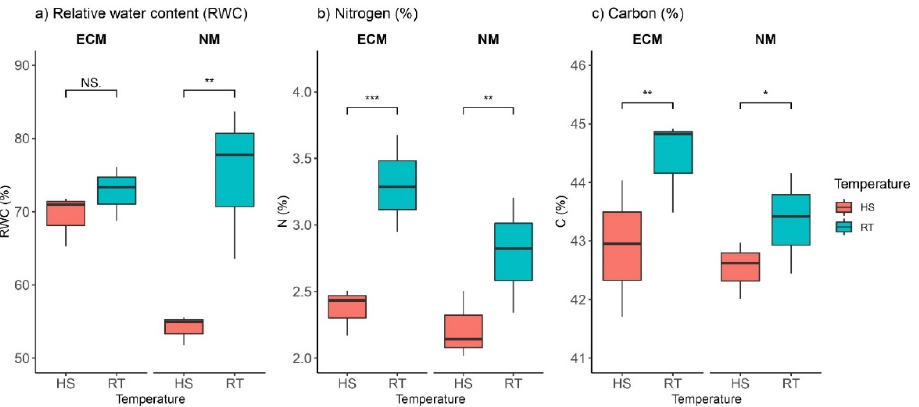
Figure 1. Changes in ( a ) relative water content (RWC, %), ( b ) nitrogen content (N, %), and ( c ) car- bon content (C, %) in leaves of Q. robur . Treatments: HS—heat-stress-treated oak seedlings, RT—control oak seedlings grown at room temperature, ECM—oak seedlings inoculated with ec- tomycorrhiza inoculum, and NM—oak seedlings not inoculated with ectomycorrhiza inoculum. Significance levels: NS—non-significant and significant ((*) <0.05, (**) <0.01, and (***)